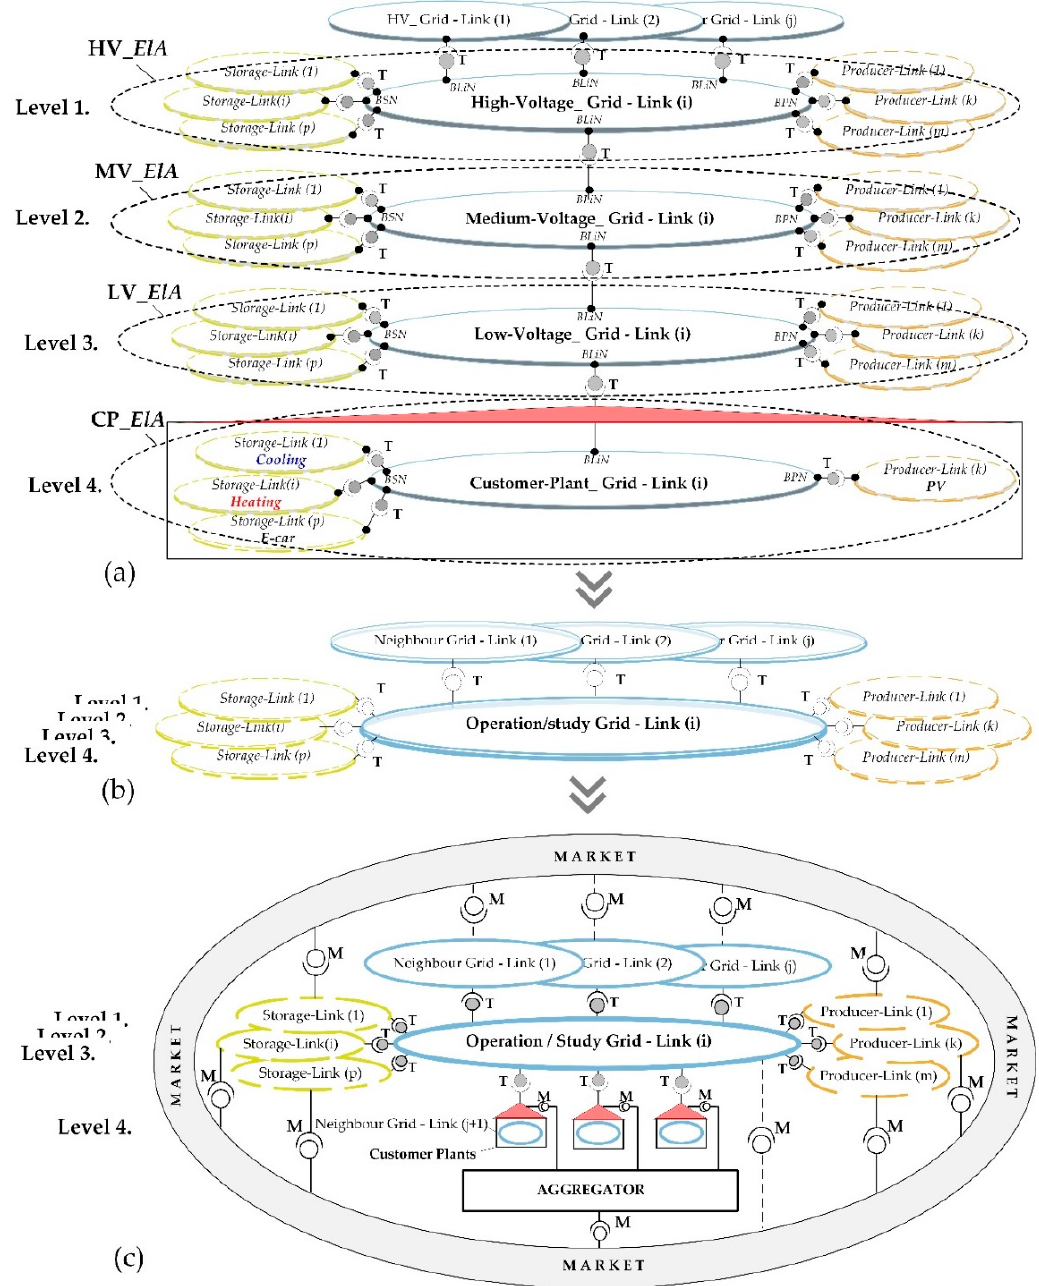
Figure 15. Different stages of the LINK -based architecture: ( a ) Technical/functional, ( b ) generalized Figure 15. Di ff erent stages of the LINK -based architecture: ( a ) Technical / functional, ( b ) generalized and and ( c ) holistic. ( c )